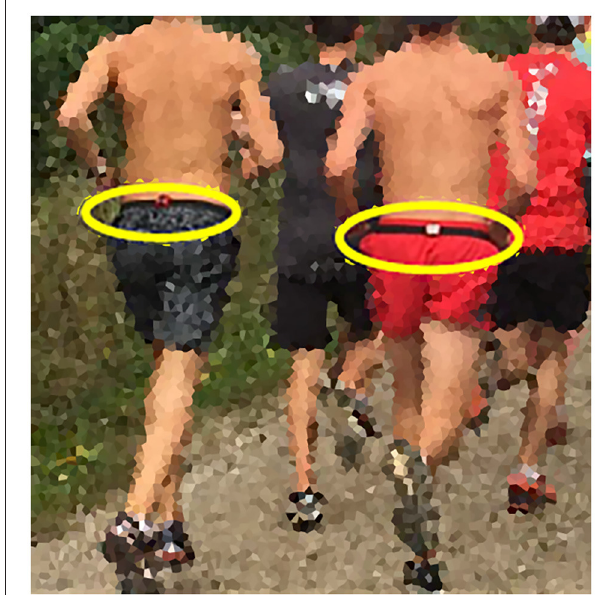
FIGURE 1 | The triaxial accelerometer (GT3 + , ActiGraph Corp, Pensacola, FL, USA; 100Hz) was positioned securely around the waist, centered over the sacrum. Participants wore the device for all “easy” continuous runs each week of the competitive season. The group baseline run is pictured in the